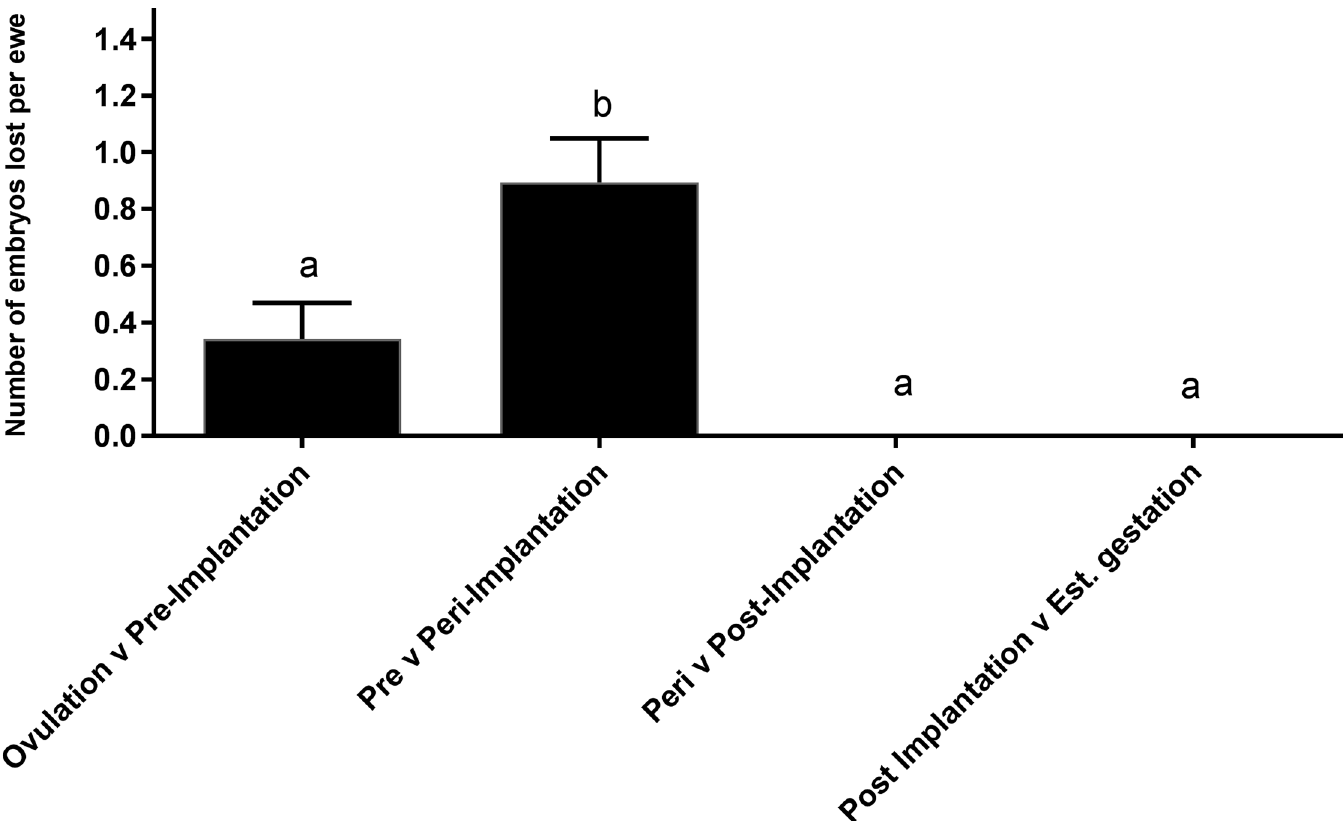
Fig 4. The number of embryos lost per ewe between each developmental period; ovulation v pre-implantation, pre v peri-implantation, peri v post-implantation and post implantation and established gestation. Valuesare mean ± SEM. Columnswithout common subscriptsdiffer significantly (P <